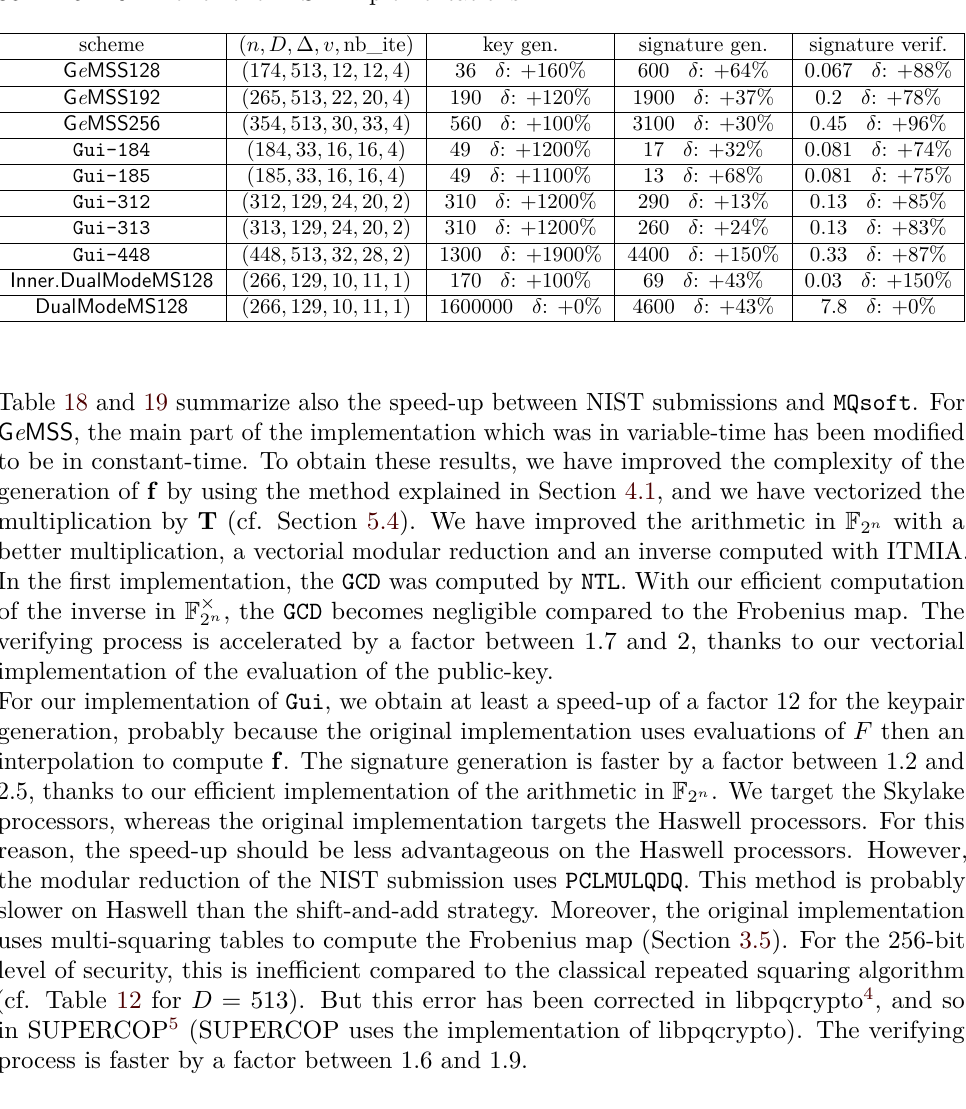
Table 19: Number of mega cycles (Mc) for each cryptographic operation with our li- brary for a Skylake processor (DesktopS), followed by the speed-up between the best implementation provided for the NIST submissions versus our implementation. For exam- ple, 36 δ : +160% means a performance of 36 Mc with MQsoft , and a performance of 36 × 2 . 6 = 94 Mc for the NIST